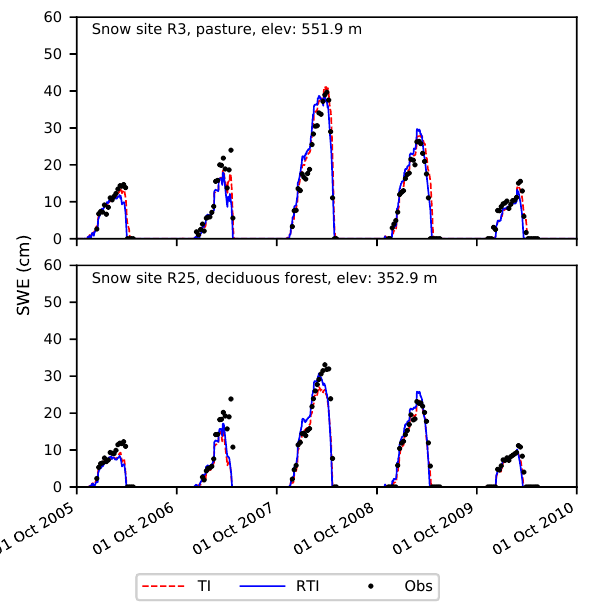
Figure 5. TI and RTI simulated SWE at R3 and R25 snow sites within the W-3 watershed.